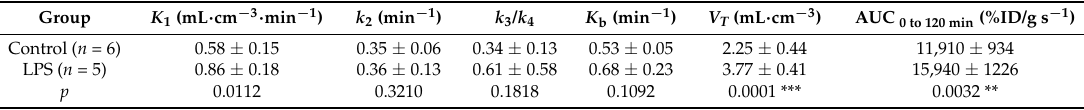
Table 1. Pharmacokinetics parameters for [ 18 F]FEPPA in the whole mice brain.